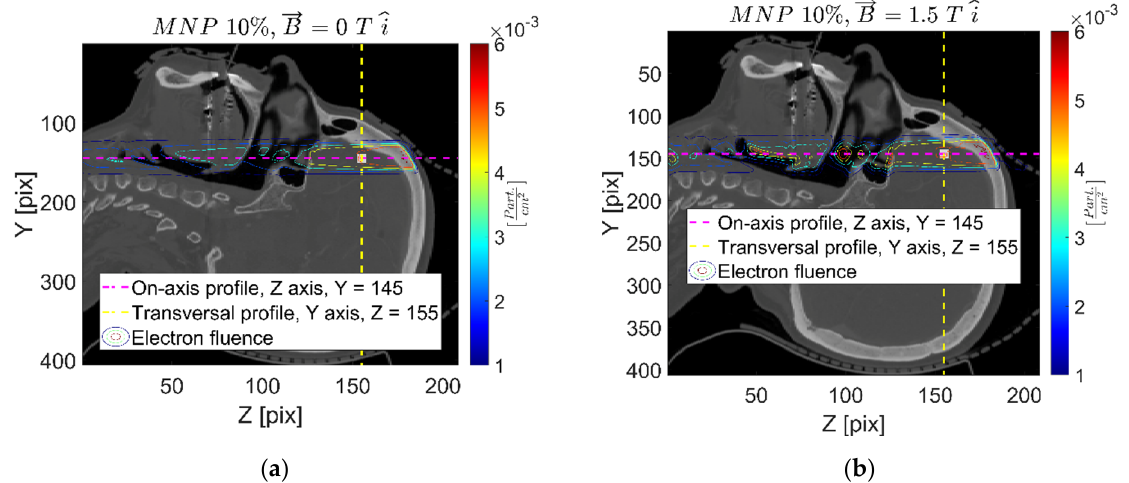
Figure 3. Secondary charged particle fluence map, sagittal plane, for 10 ‐ 0 ( a ) and 10 ‐ 1.5x ( b ) cases. Figure 4 shows a representative dose distribution example, reporting the transversal dose map for the 1% w / w and 1.5 T in the x ‐ axis direction (1 ‐ 1.5x) and reference cases along with the corresponding dose profiles within a region of interest (ROI) around the MNP ‐ infused target.